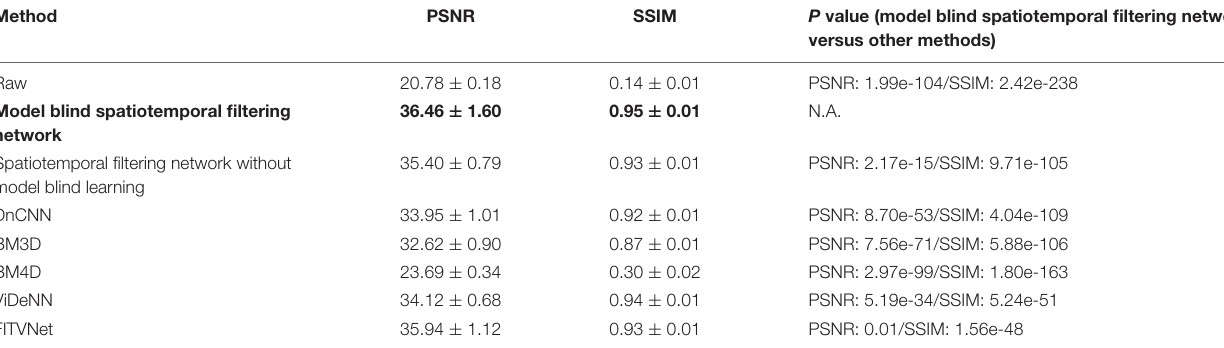
TABLE 1 | Comparison of denoising performances for the raw two-photon Ca 2 + imaging dataset in terms of PSNR and SSIM.